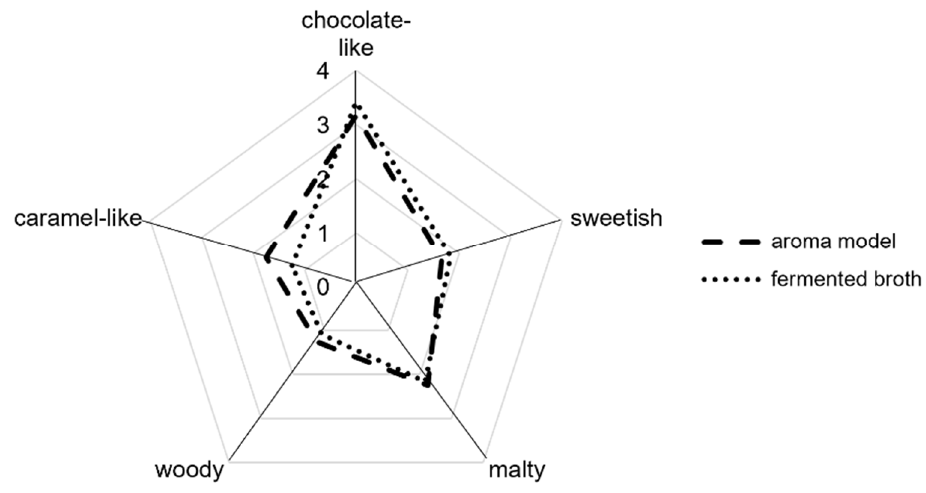
Figure 2. Comparative sensory analysis of the fermented green tea broth with M. scorodonius and the reconstituted aroma model in water by the panel ( n = 12).